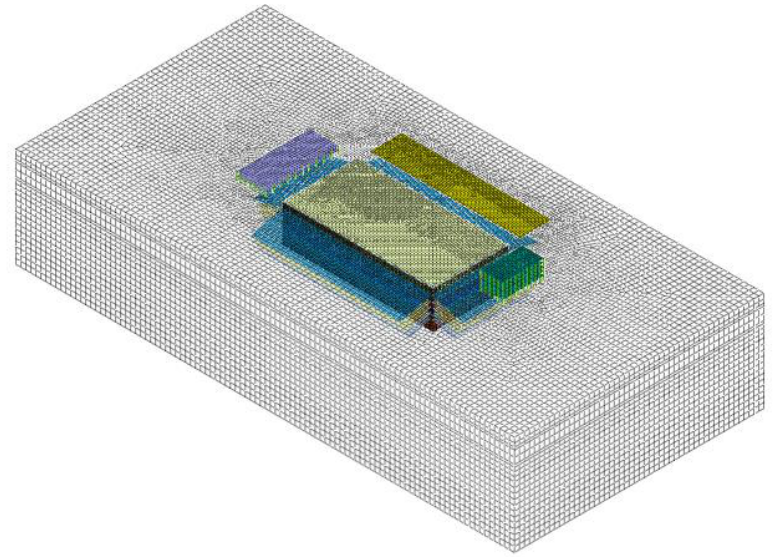
Figure 9. The finite element model of the foundation pit.